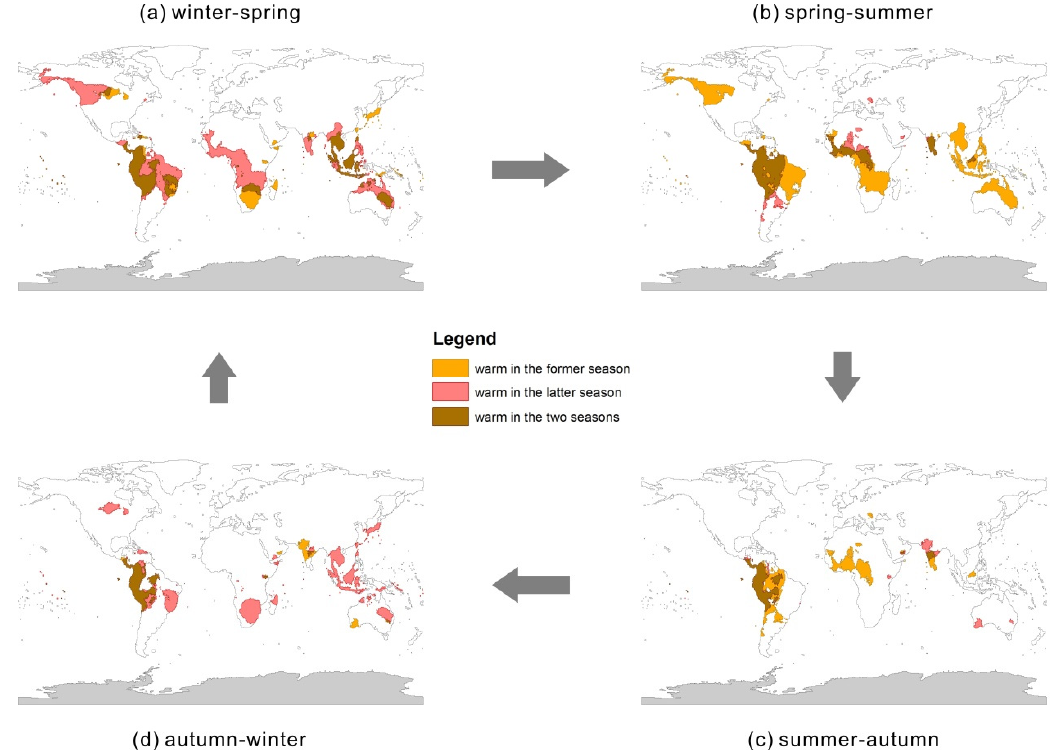
Figure 3. The warm flocks of the adjacent seasons. ( a ) The warm flocks of boreal winter and boreal spring. ( b ) The warm flocks of boreal spring and boreal summer. ( c ) The warm flocks of boreal summer and boreal autumn. ( d ) The warm flocks of boreal autumn and boreal winter.